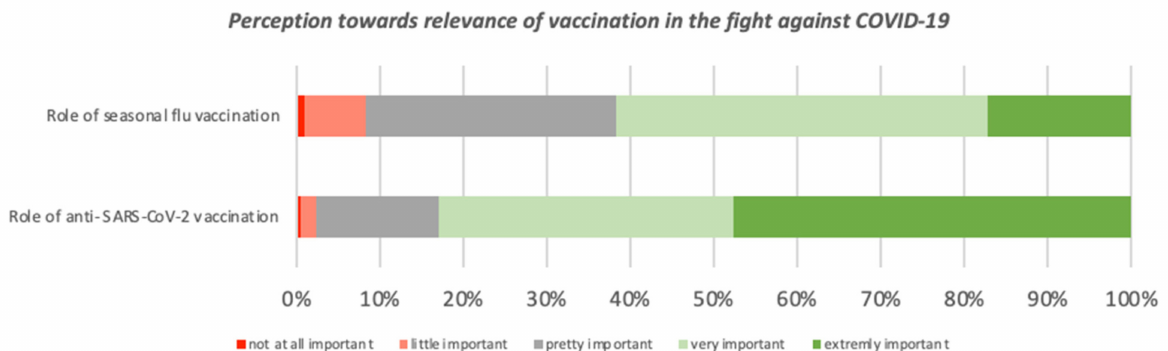
Figure 4. Perception of 1723 participants towards relevance of vaccinations in the fight against